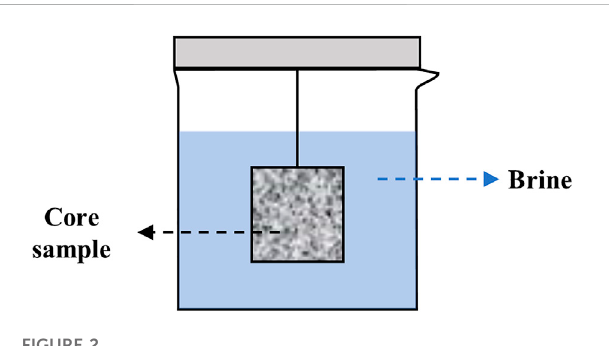
FIGURE 2 The diagram of spontaneous imbibition